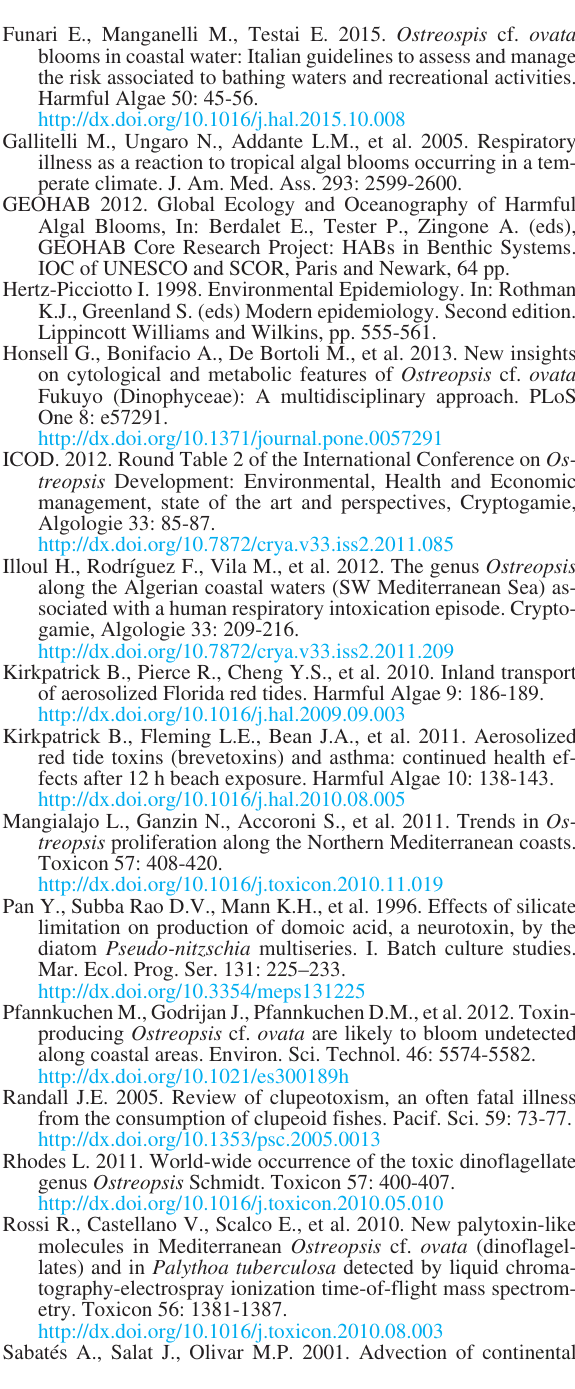
Table S1. – Daily health questionnaire